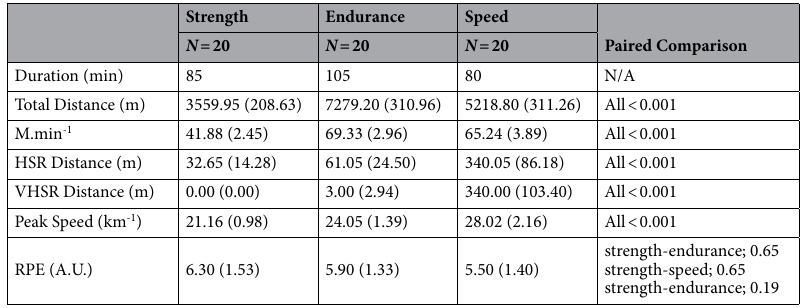
Table 2. Summary descriptive table (average (SD)) by groups of `football session type’. N/A not applicable, A.U. arbitrary units, M min −1 m per minute, HSR high-speed running > 19.8 km −1 , VHSR very high-speed running > 25.2 km −1 , RPE rating of perceived exertion.